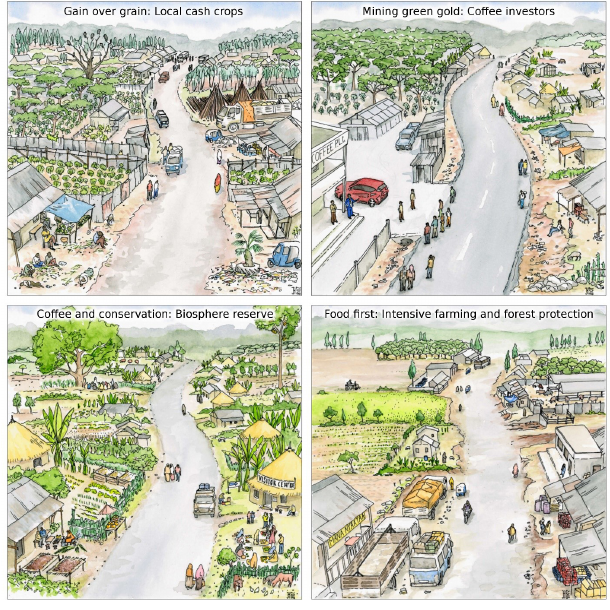
Fig. 3 . Visual representation of the key features of the four scenarios in terms of landscape features and composition in a village. The “gain over grain” scenario is characterized by a landscape consisting of coffee, khat, and eucalyptus, with settlement areas providing local markets for these cash crops. Infrastructure such as roads to the investment area is improved, and the landscape harbors coffee plantations in the “mining green gold” scenario. Traditional lifestyles where settlements are interspersed with forest and diverse crops characterize the “coffee and conservation” scenario. Areas of consolidated and intensively used farmland, fruit tree plantation, and intensive cattle raising characterize the “food first”